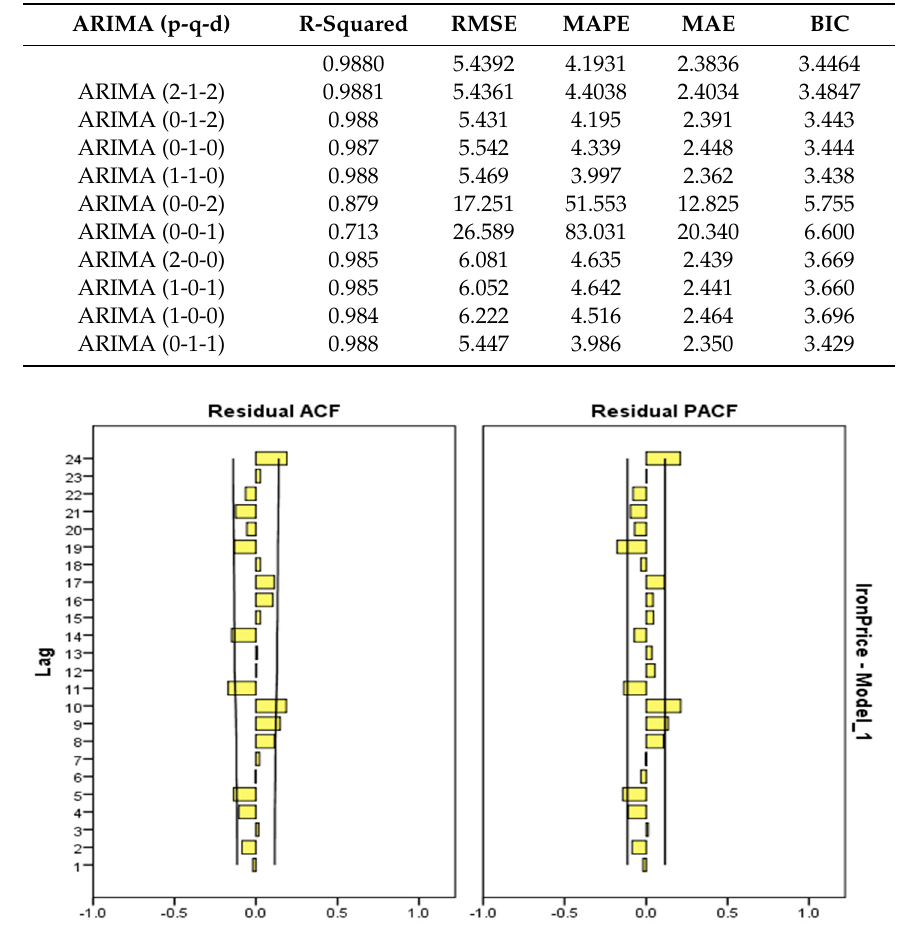
Table 2. Statistical results of different autoregressive integrated moving average (ARIMA) parameters for iron ore price forecasting.